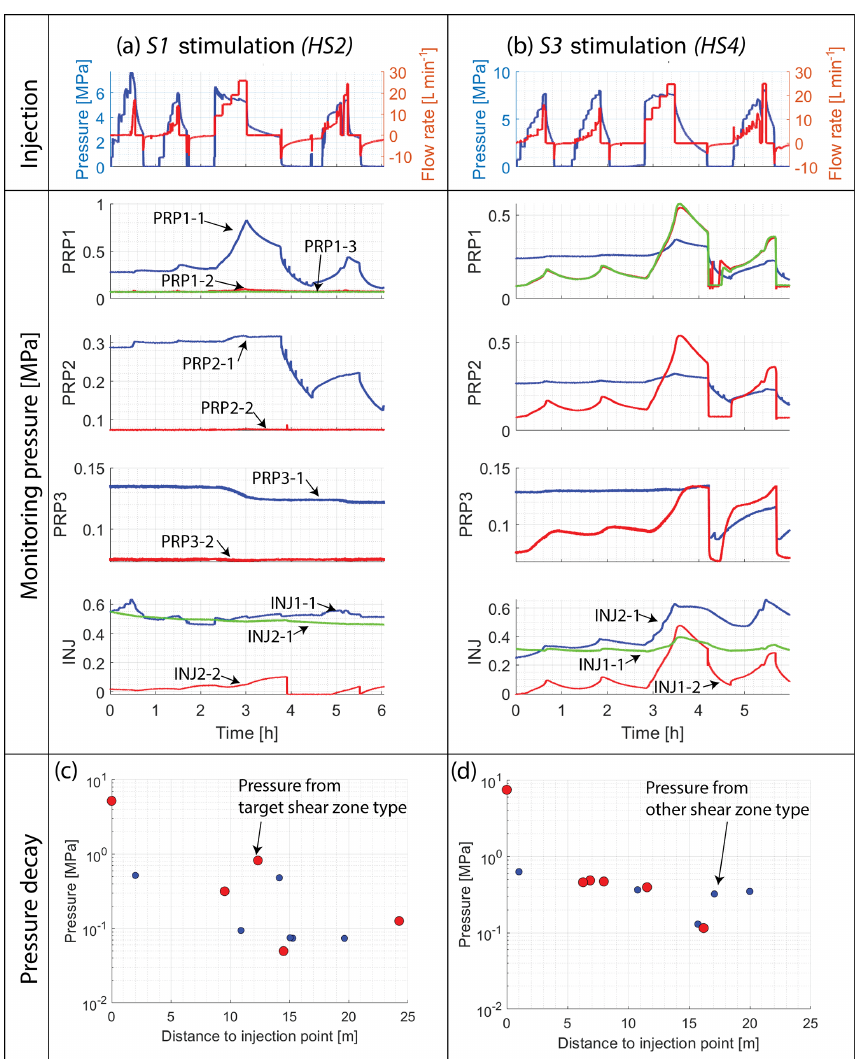
Figure 8. Pressure data for HS2 and HS4 are shown in panels (a) and (b) , respectively. Injection protocols for both experiments are shown at the top. In the middle, the corresponding time series of pressure recorded at the various intervals of the PRP boreholes are plotted. Panels (c) and (d) show the pressures prevailing in the intervals at the end of the final step of the stimulation injection cycle plotted against the distance to the injection point for HS2 (a) and HS4 (b) ,